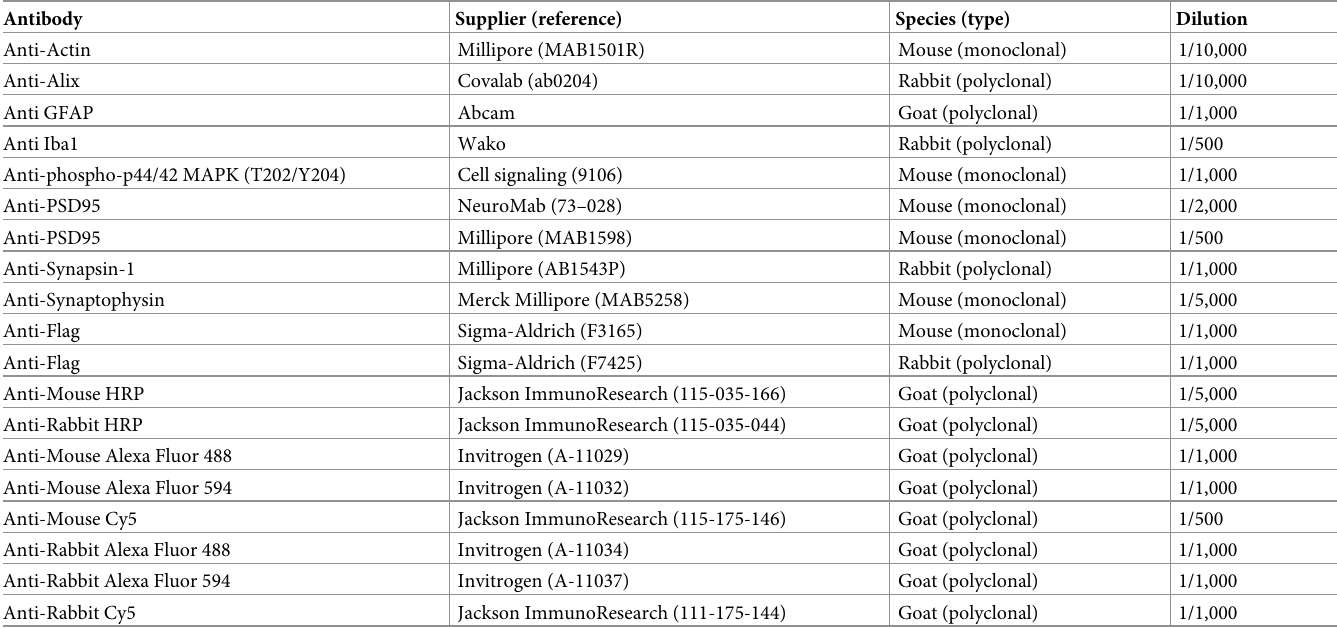
Table 1. List of the antibodies used in this